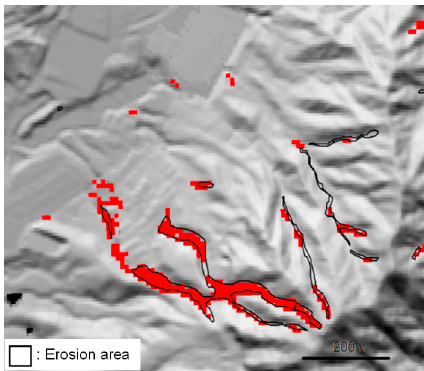
Figure 10. Detected pixels (red) by the fusion analysis in this study with erosion areas visually identified from aerial photographs.